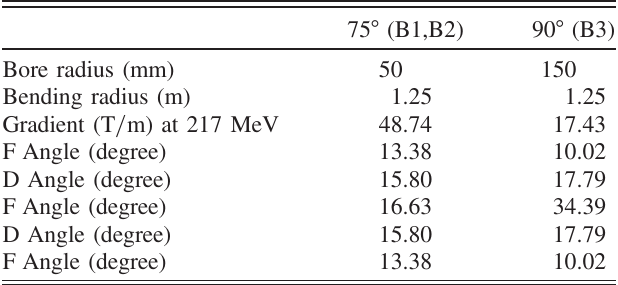
TABLE II. Properties of the 90° and 75° AG-CCT magnets (SCOFF